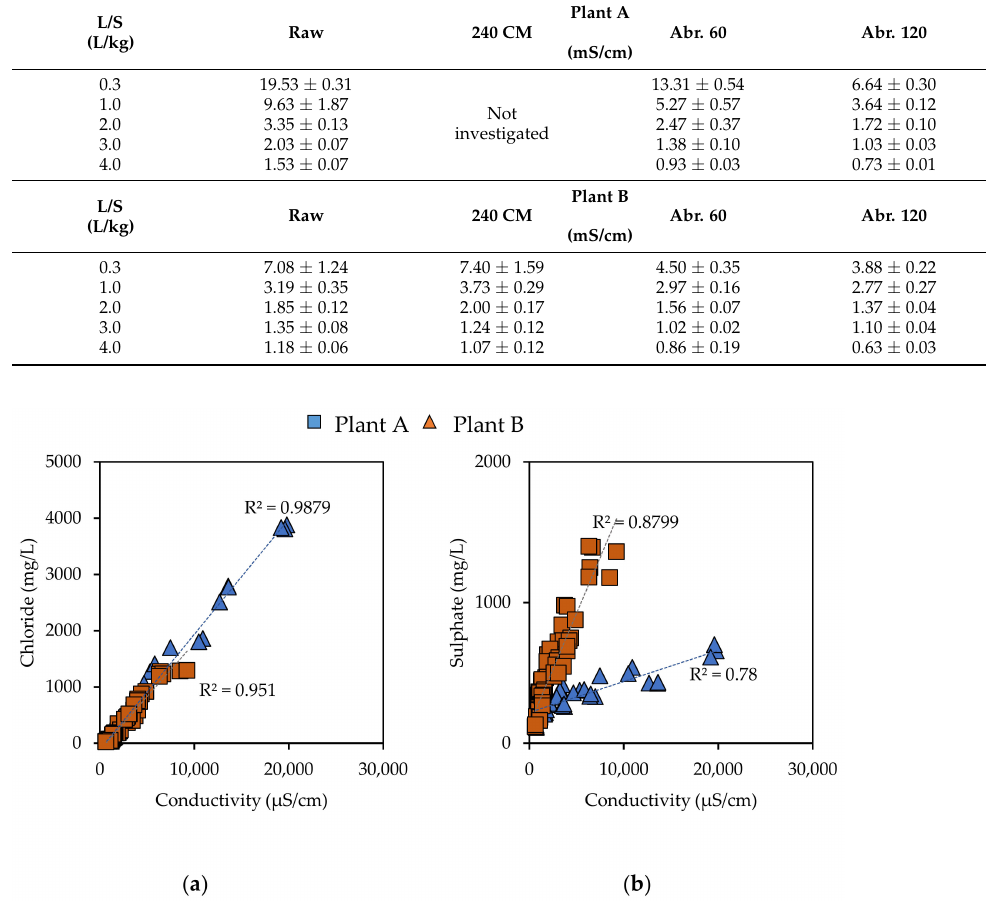
Figure 5. Correlations between electrical conductivity and ( a ) chloride and ( b ) sulphate concentra- tions in the